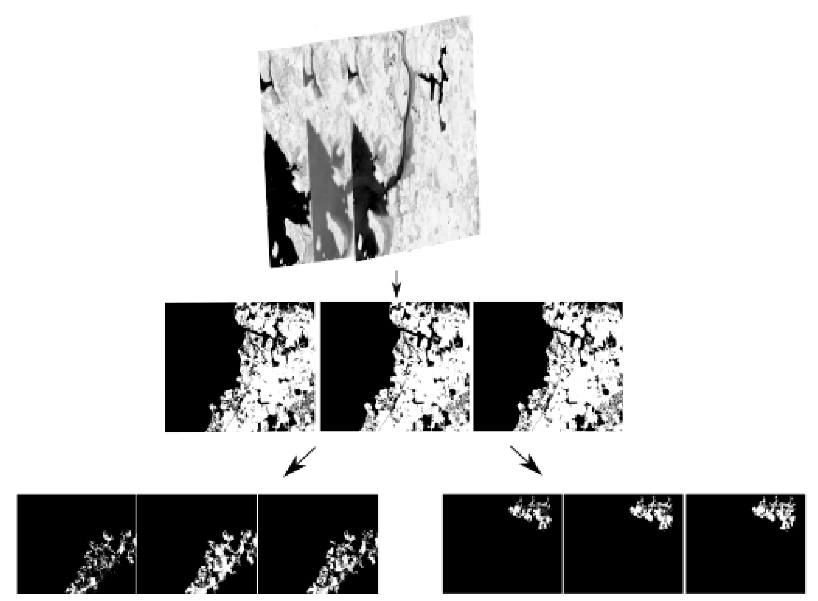
Figure 2. Space-time max-tree example built from real remote sensing data. The tree is built with 3 images and nodes include up to three images.